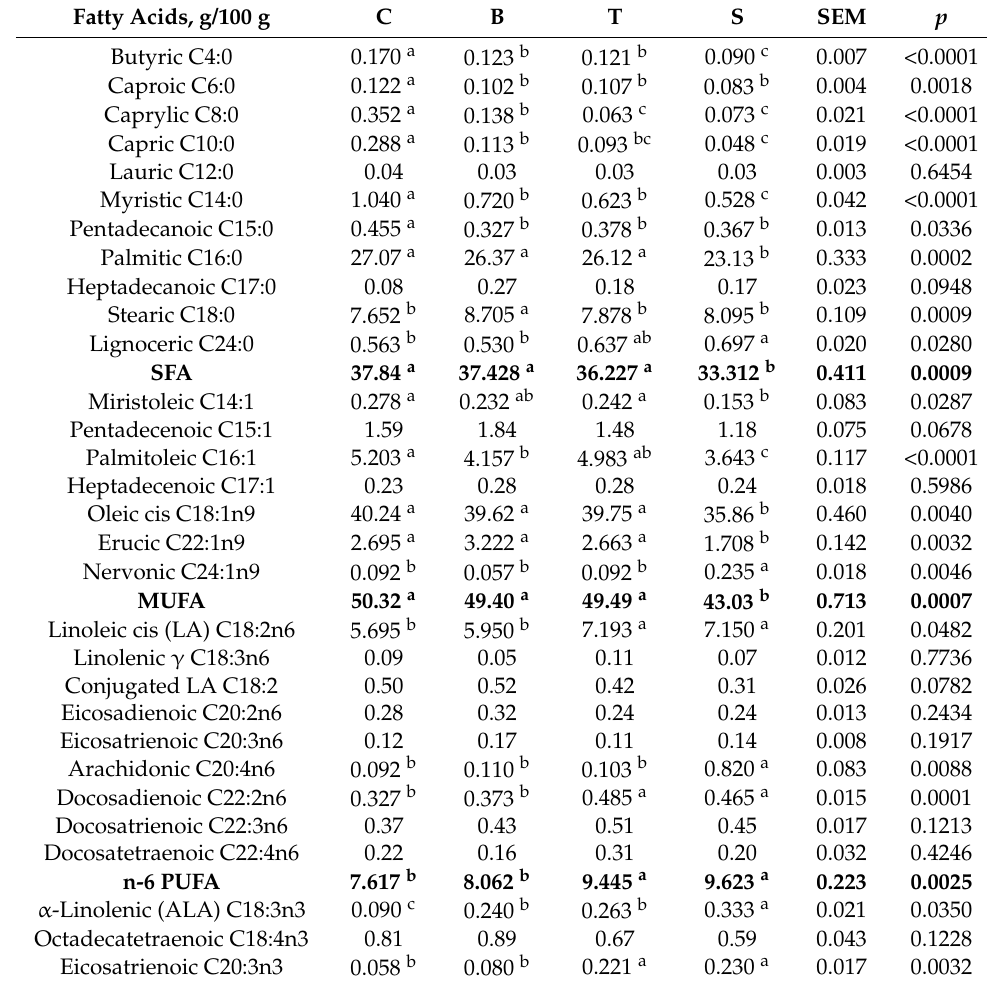
Table 4. Effect of dietary plants on fatty acid profiles (g/100 g) of thigh meat. Fatty Acids, g/100